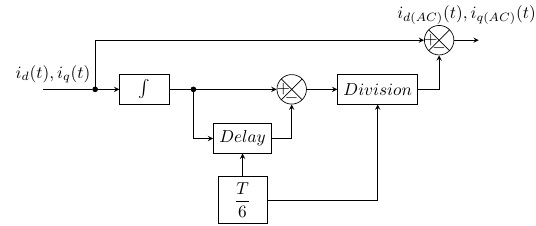
Figure 7. Modified SRF with eliminated LPF